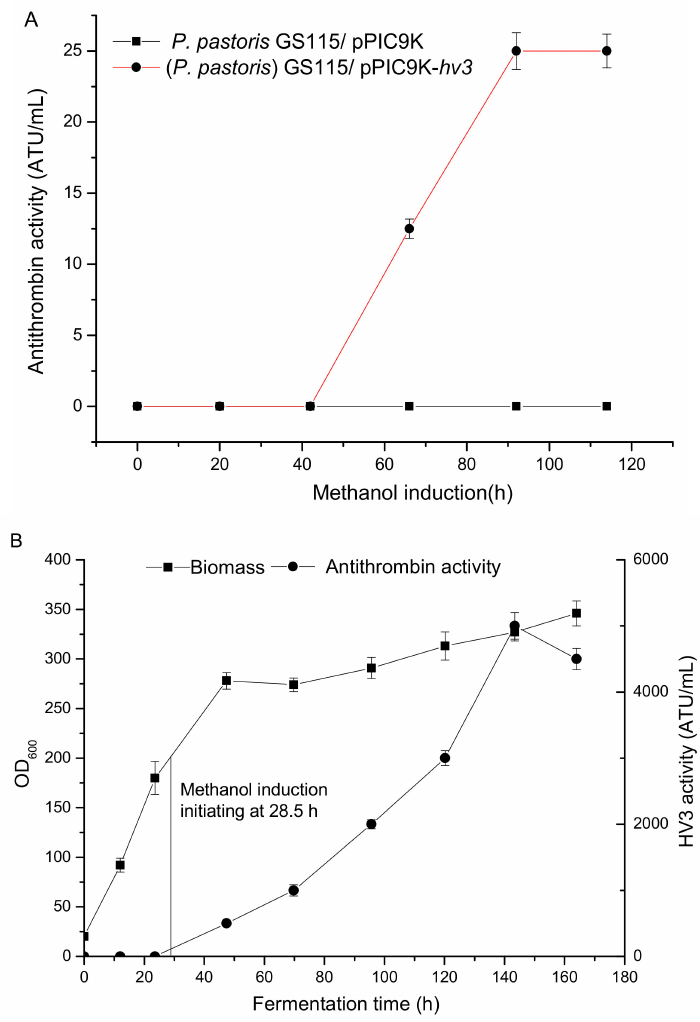
Figure 1. HV3 expression in the recombinant P. pastoris GS115 / pPIC9K- hv3 ( A ) and its fermentation curve in 5 L fermenter ( B